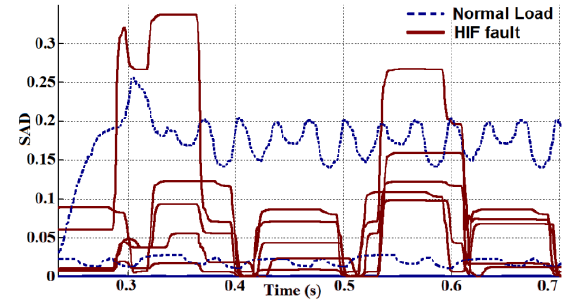
Figure 15. SAD for several cases.